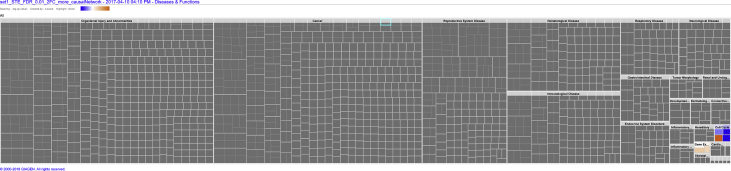
Square map showing the enriched disease and biological functions by STE. The square map was colored based on the z-score, which is a statistical measure of the match between expected relationship direction and observed gene expression. The color scale represents the activation z-score ranging from −1.785 (dark blue) to 0.212 (dark orange). A z-score > 2 or < −2 is considered significant. The actual z-score is weighted by the underlying findings, the relationship bias, and dataset bias.